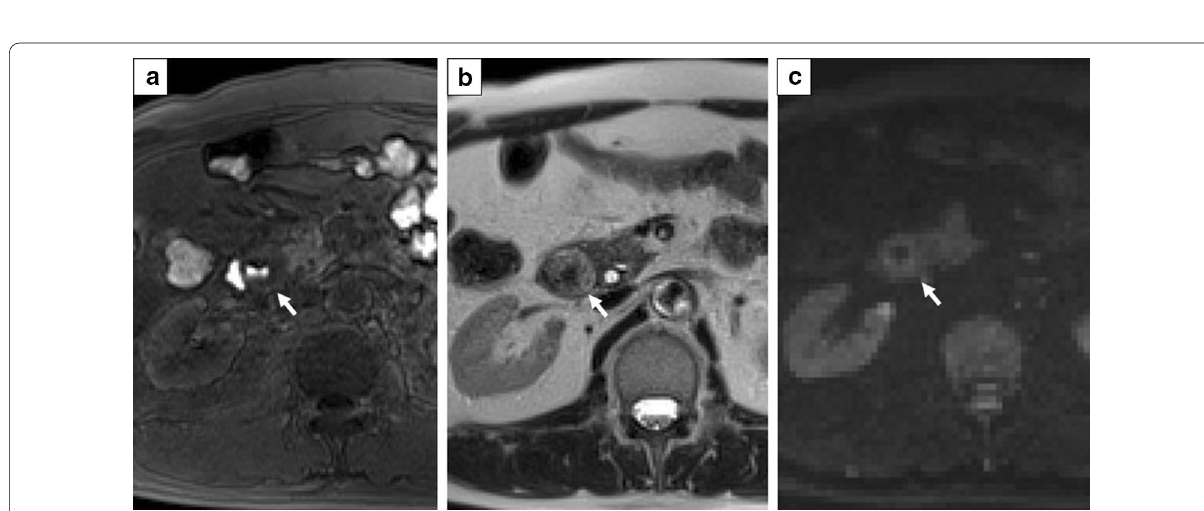
Fig. 2 a The tumor revealed hypo-intensity on T1-weighted image. b The tumor shows a modestly high intensity on T2-weighted imaging. c The tumor shows a slightly high intensity on diffusion-weighted